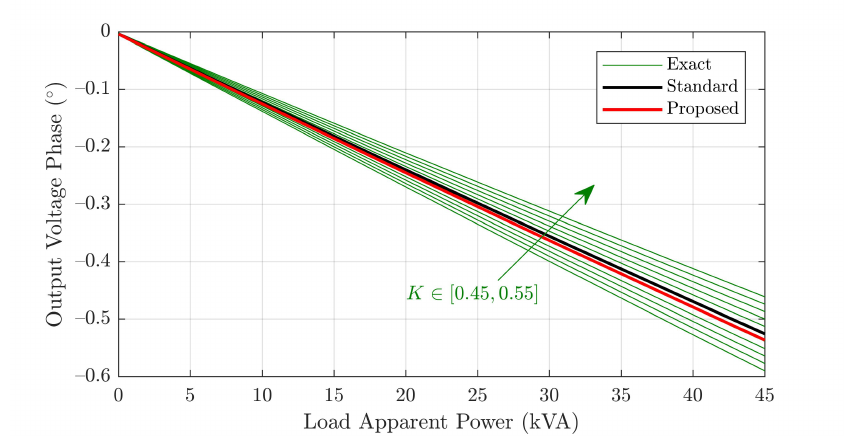
Figure 11. Output voltage phase versus load for the different